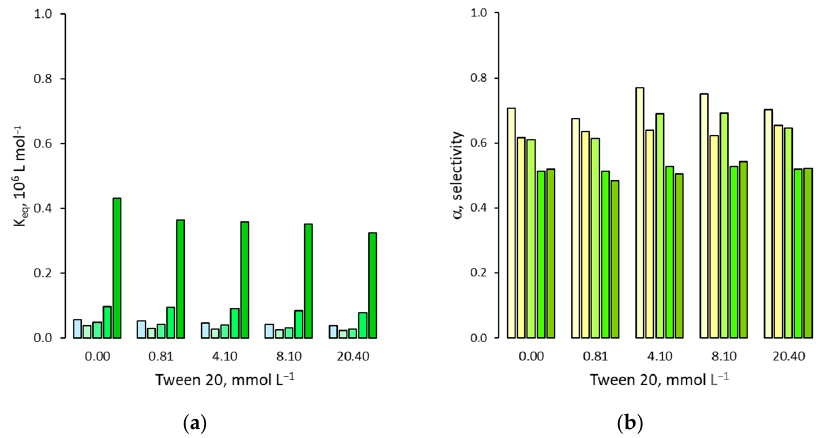
Figure 7. ( a ) Binding affinity of 2,4-D for the MIP in presence of increasing amounts of Tween 20; ( b ) Binding selectivity. For each group of bars from left to right: water molar fraction from 0 (pure acetonitrile) to 0.24, 0.42, 0.66 and 0.81.